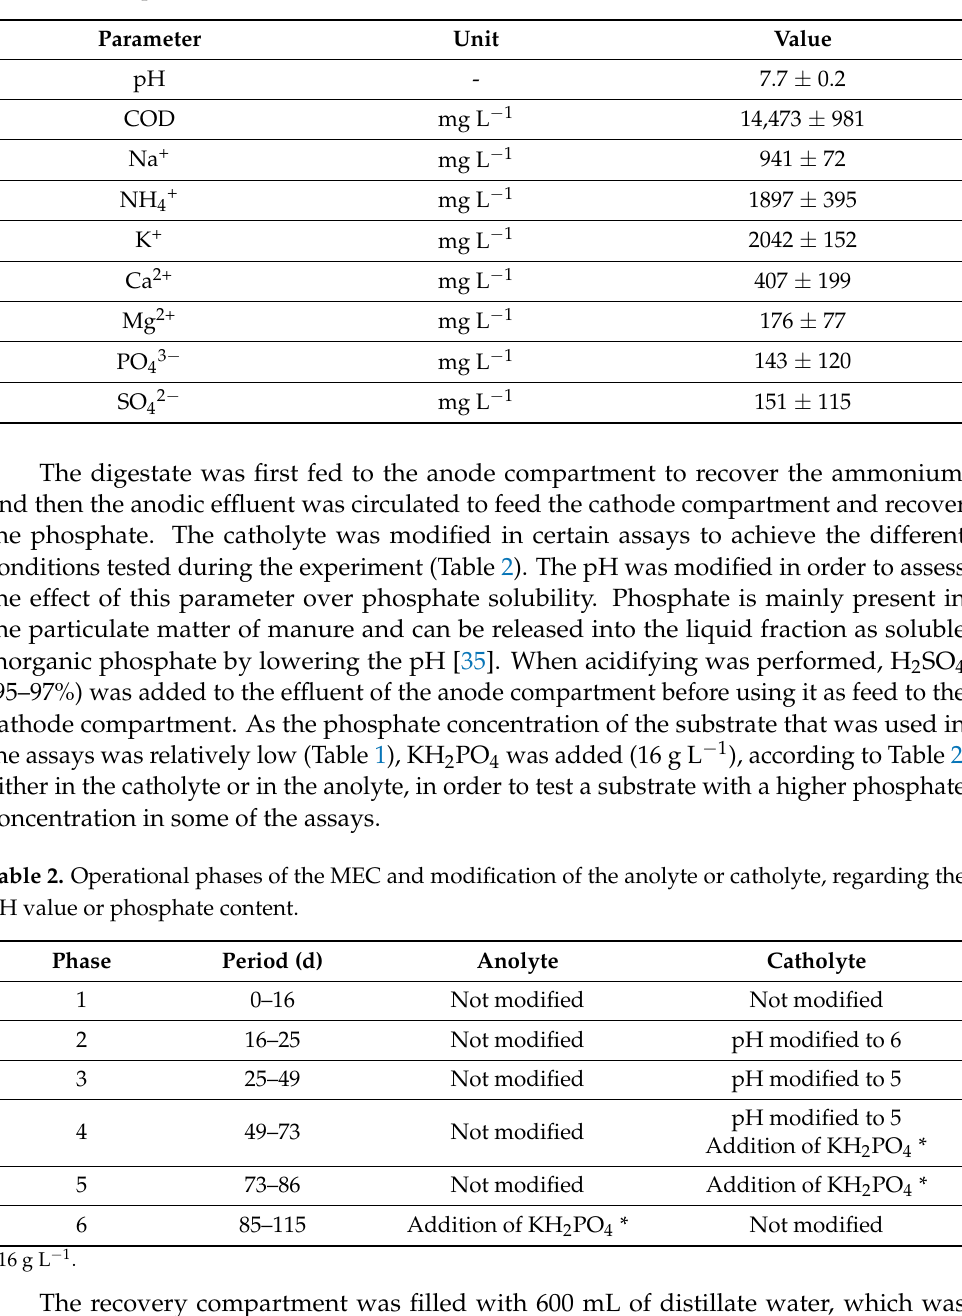
Table 1. Composition of the digested pig slurry used as the substrate (average ± standard deviation). Number of samples, n = 8.